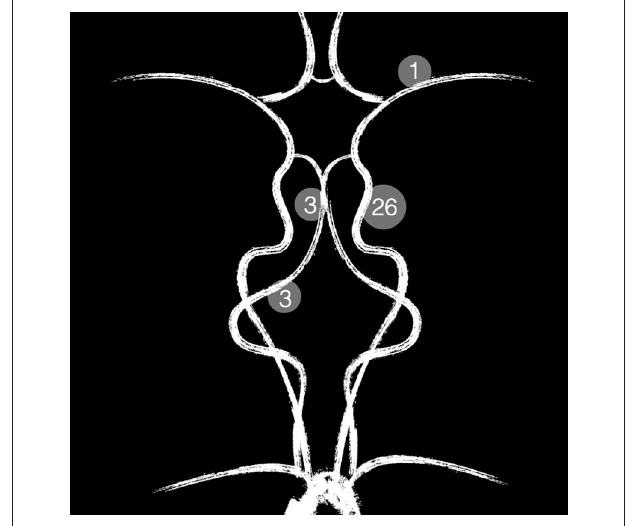
FIGURE 1 | Summary of the anatomical distribution of the treated